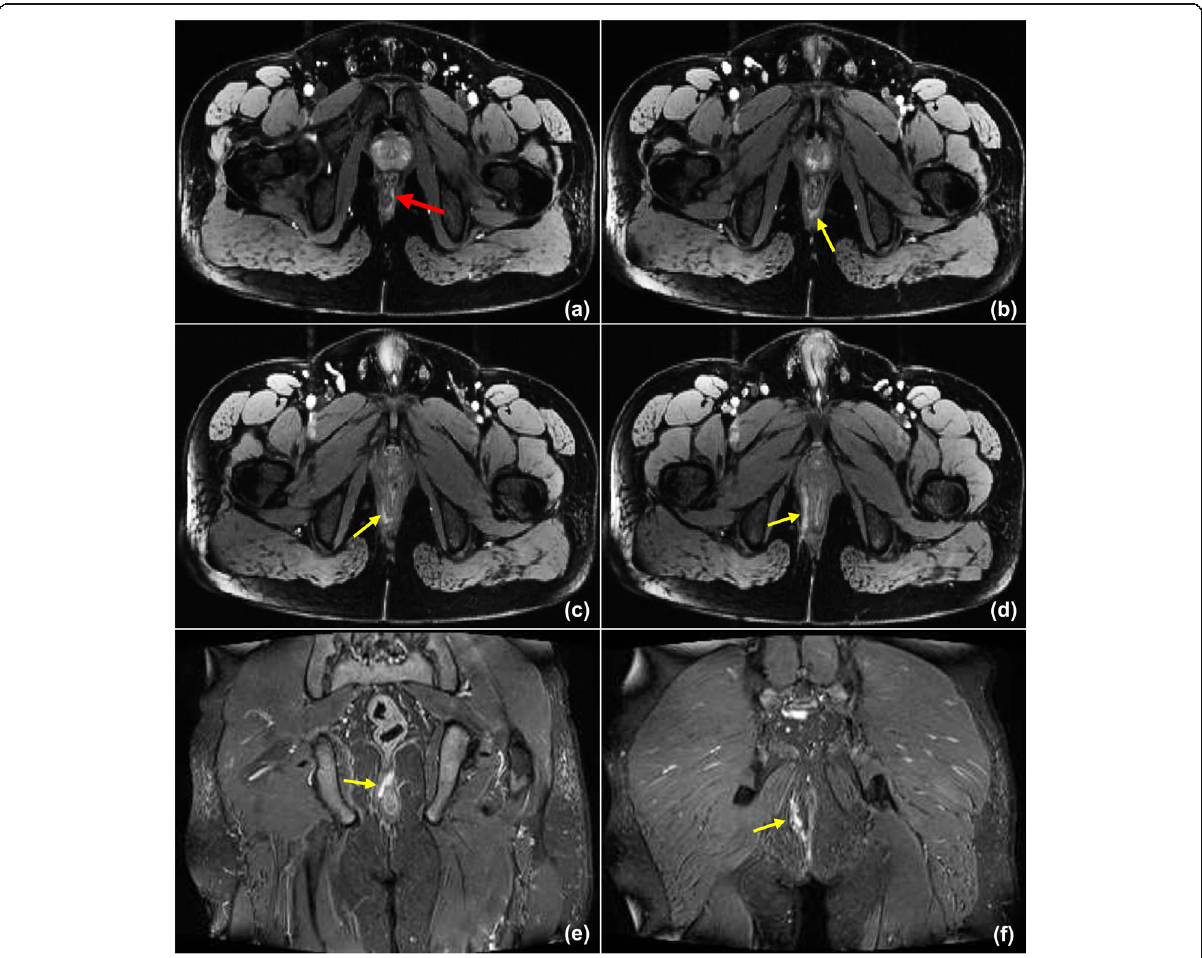
arrow demonstrates the level of internal opening in the lateral wall of the rectum while the yellow arrows demonstrate the course of track as high signal